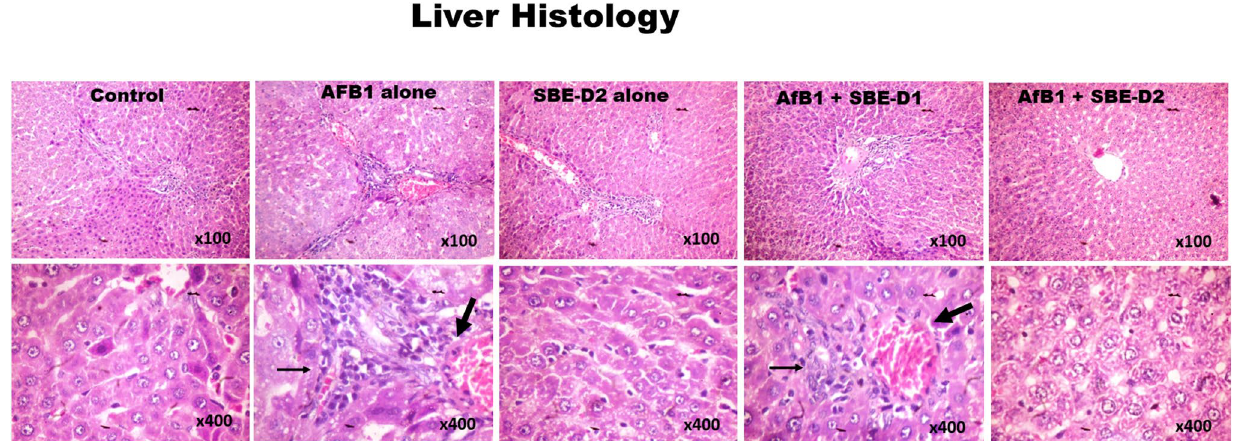
Figure 9. Control Plates of the liver show a focal area of mild congestion and apoptotic bodies with typical tissue architecture. AFB 1 alone show areas of focal congestion (bold arrows), infiltration of zone 2 by inflammatory cells, mild hydropic/ballooning degeneration of the hepatocytes and moderate microvesicular steatosis (tiny arrows). SBE-D2 alone plate tissue morphologies are like those from control. AFB 1 with SBE-D1 and SBE-D2 plates improved hepatic cyto-architecture with mild focal congestion and infiltration of zone 2 by inflammatory cells. H and E-stained sections; Magnification at × 100 top panel; × 400 lower